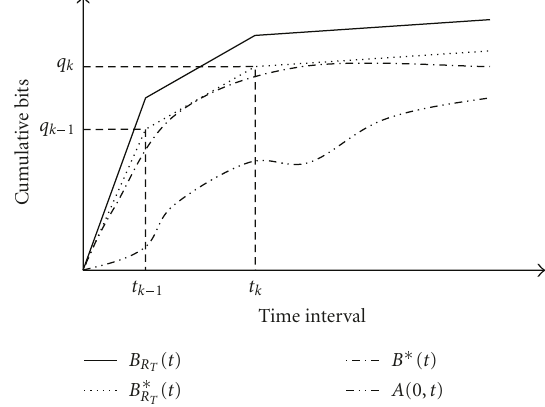
Figure 2: Illustration of tra ffi c constraint